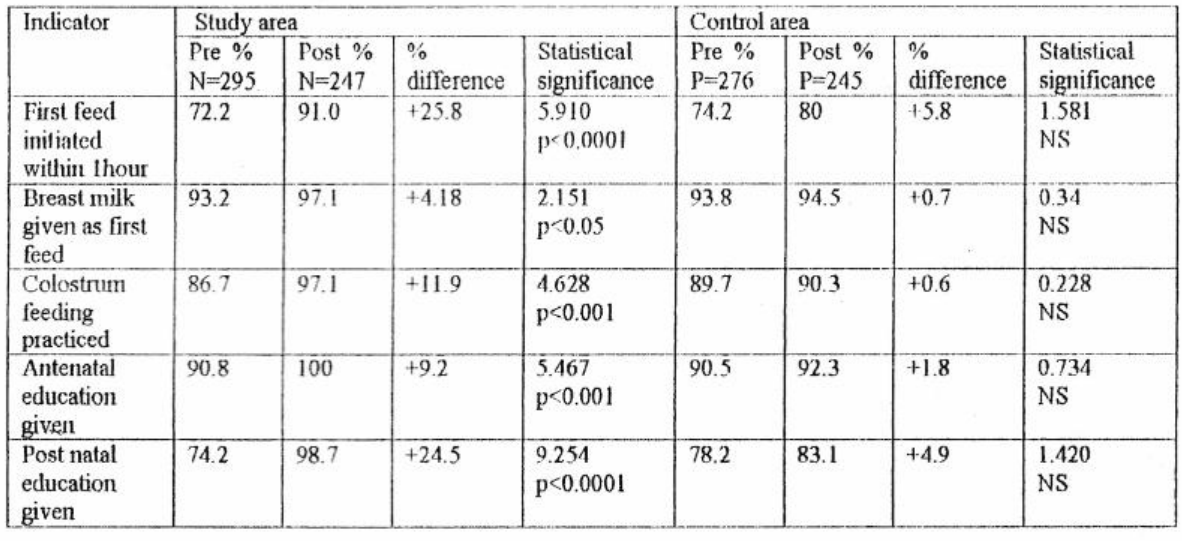
‘Table 2 : Percentage change inpractices promoting breast feeding practices instudy and control areas — pre and postintervention